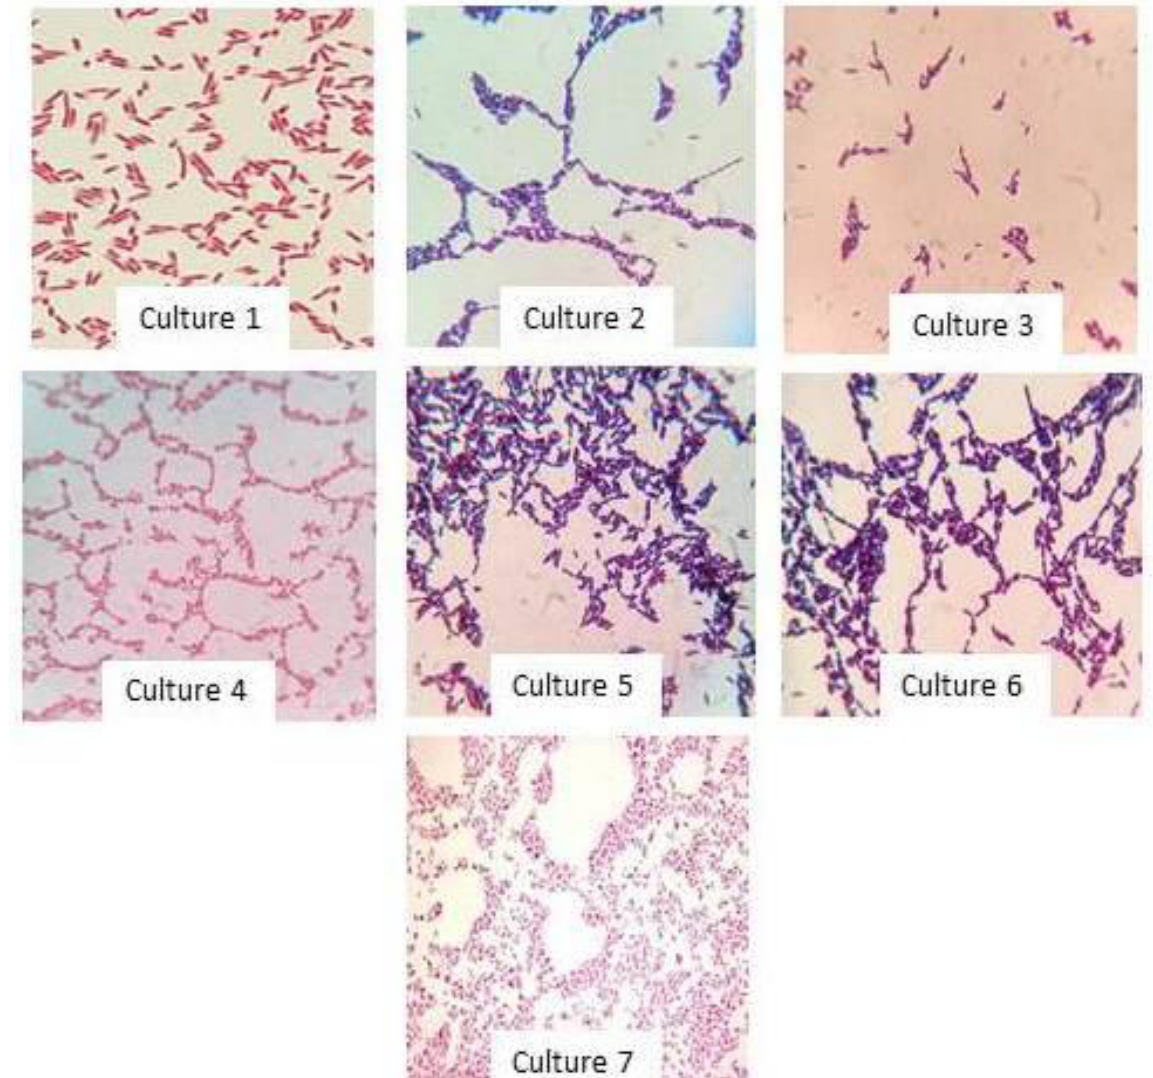
Fig. 9. Bacterial cultures under microscope after Gram